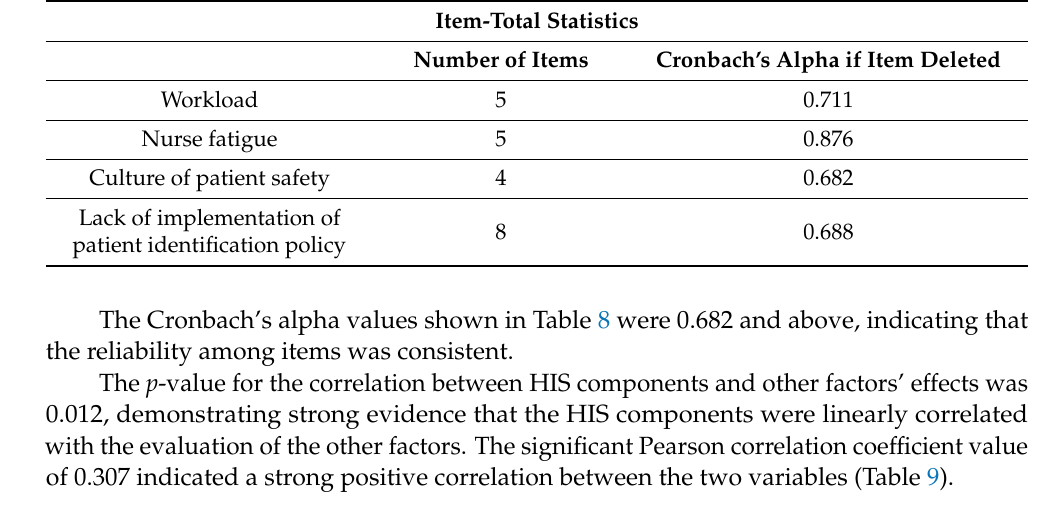
Table 9. Correlations between HIS components and other factors’